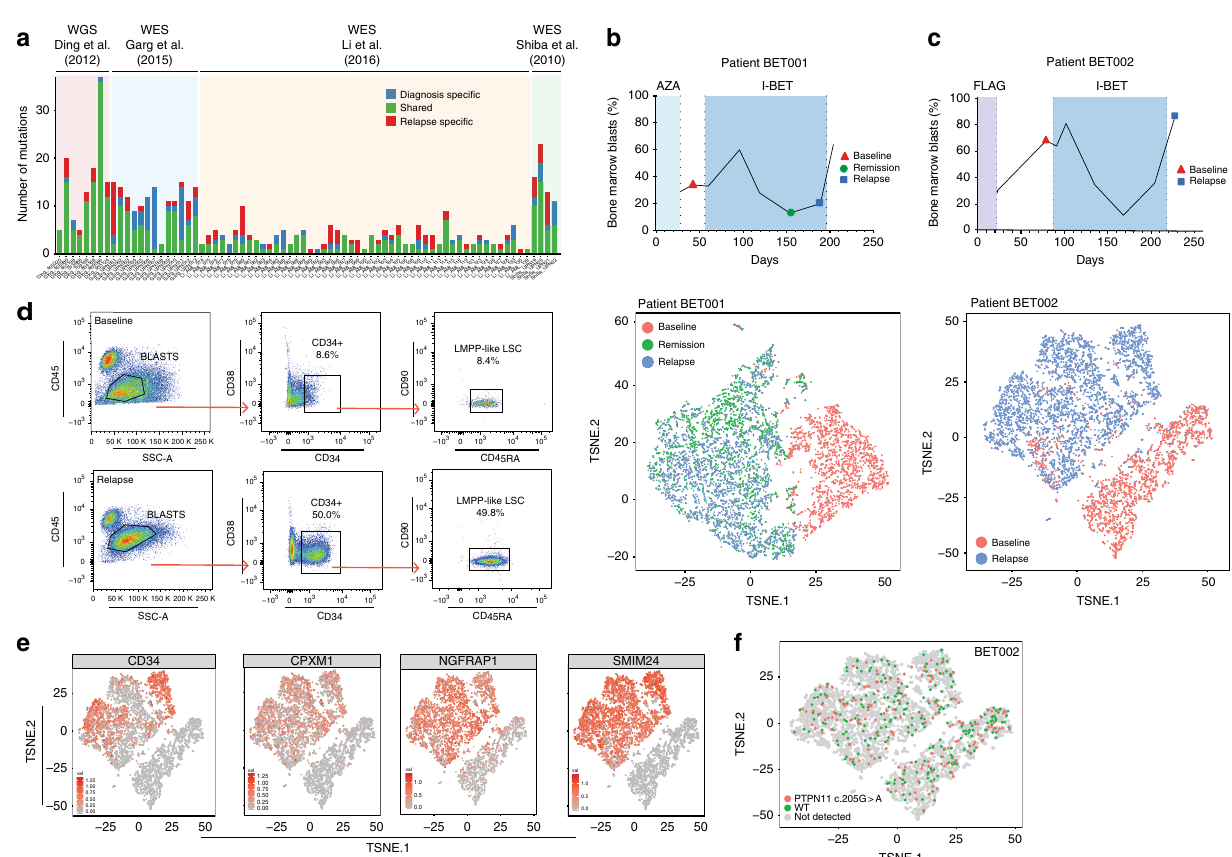
Fig. 1 Non-genetic adaptation drives clinical resistance in AML. a Meta-analysis from four independent studies analysing either the whole genome or whole exome of AML patients at diagnosis and relapse. Mutations are de fi ned as non-synonymous changes within the coding sequence of any gene. Shared mutations are mutations present at both diagnosis and relapse. Whole exome sequencing data from Li et al. (REF 4) was analysed to access the mutations in known AML genes, as de fi ned by the authors. b Schematic of the treatment regime and bone marrow blast percentage for patient BET001 over the clinical trial treatment course (top panel). t-SNE analysis of 7360 individual blast cells isolated from patient BET001 at baseline, remission and relapse (bottom panel). scRNA-seq and genomic DNA sampling points are highlighted on the schematic. c Schematic of treatment regime and bone marrow blast percentage for patient BET002 over the clinical trial treatment course (top panel). t-SNE analysis of 6349 single blast cells isolated from patient BET002 at baseline and relapse (bottom panel). scRNA-seq and genomic DNA sampling points are highlighted on the schematic. d Flow cytometry analysis of cells from patient BET002 at baseline and relapse identi fi es enrichment for LMPP-like LSCs at relapse based on CD34 + CD38-CD90-CD45RA + expression. Gating strategy is de fi ned by boxes. e Expression analysis of selected LSC signature genes (de fi ned in REF 15) in blast cells from patient BET002 overlaid onto the t-SNE plot. f Expression of mutant PTPN11 (c.205 G > A) and WT PTPN11 in blast cells from patient BET002 overlaid onto the t-SNE plot. Mutant PTPN11 transcripts were detected in 70 baseline blast cells and 112 relapse blast cells. WGS whole genome sequencing. WES whole exome